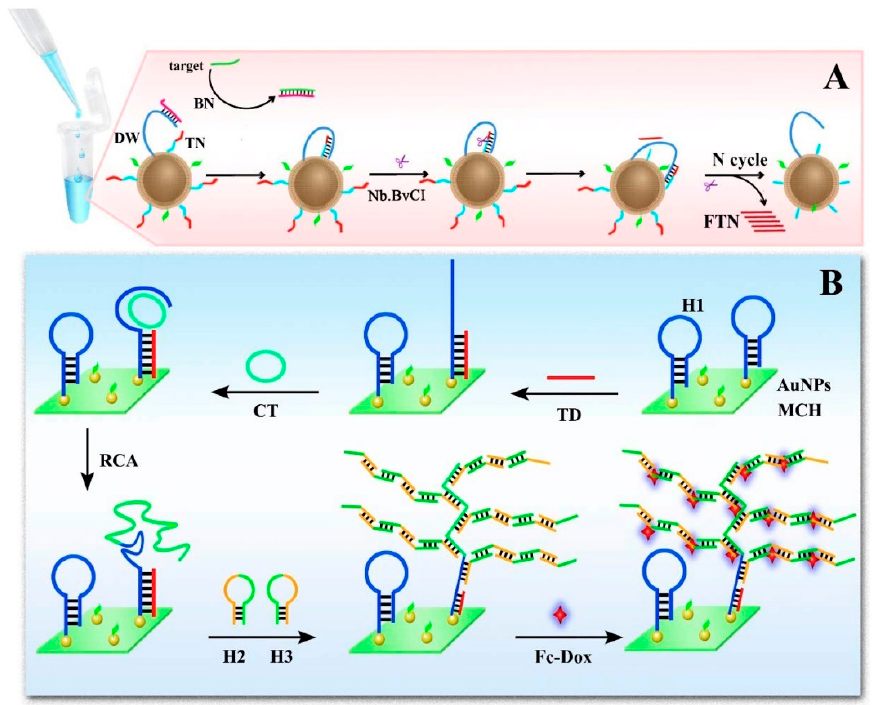
Figure 2. Schematic illustration of the electrochemical biosensor for E. coli O157:H7 detection. ( A ) Schematic illustration of the 3D DNA walker-based amplification reaction triggered by the target gene for transfer oligonucleotide fragment production; ( B ) Illustration of amplification reactions based on HCR and RCA on the surface of electrode to produce long double stranded DNA sequences for greater immobilization of electrochemical indicators associated with the target gene’s concentration. (Au NPs, gold nanoparticles; BN, blocking DNA; CT, circular template; DW, DNA walker; FTN, fragment of TN; H1, hairpin DNA1; H2, hairpin DNA2; H3, hairpin DNA3; HCR, hybridization chain reaction; MCH, 6-mercapto ethanol; RCA, rolling circle amplification; TN, transfer oligonucleotide) [60] .